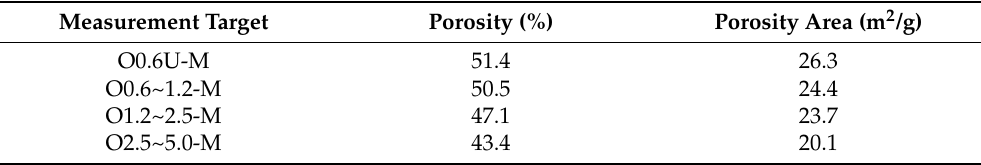
Table 5. Porosity and porosity areas of mortar containing OSA with different particle